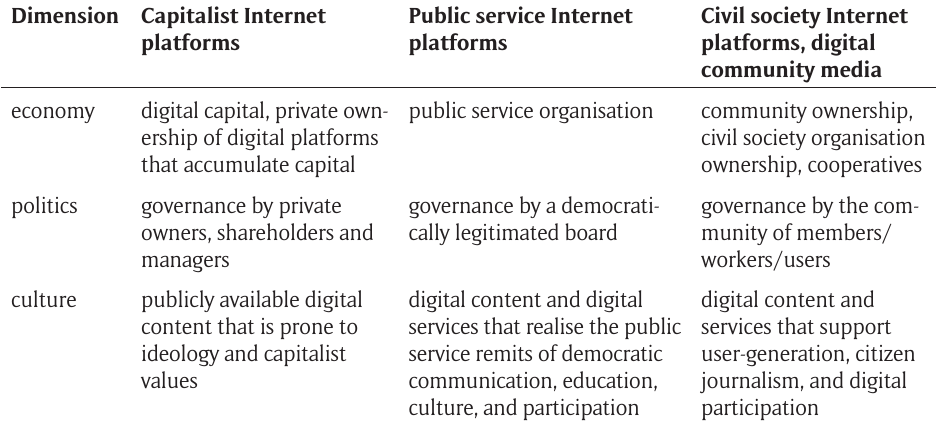
Table 4: Three political economies of digital